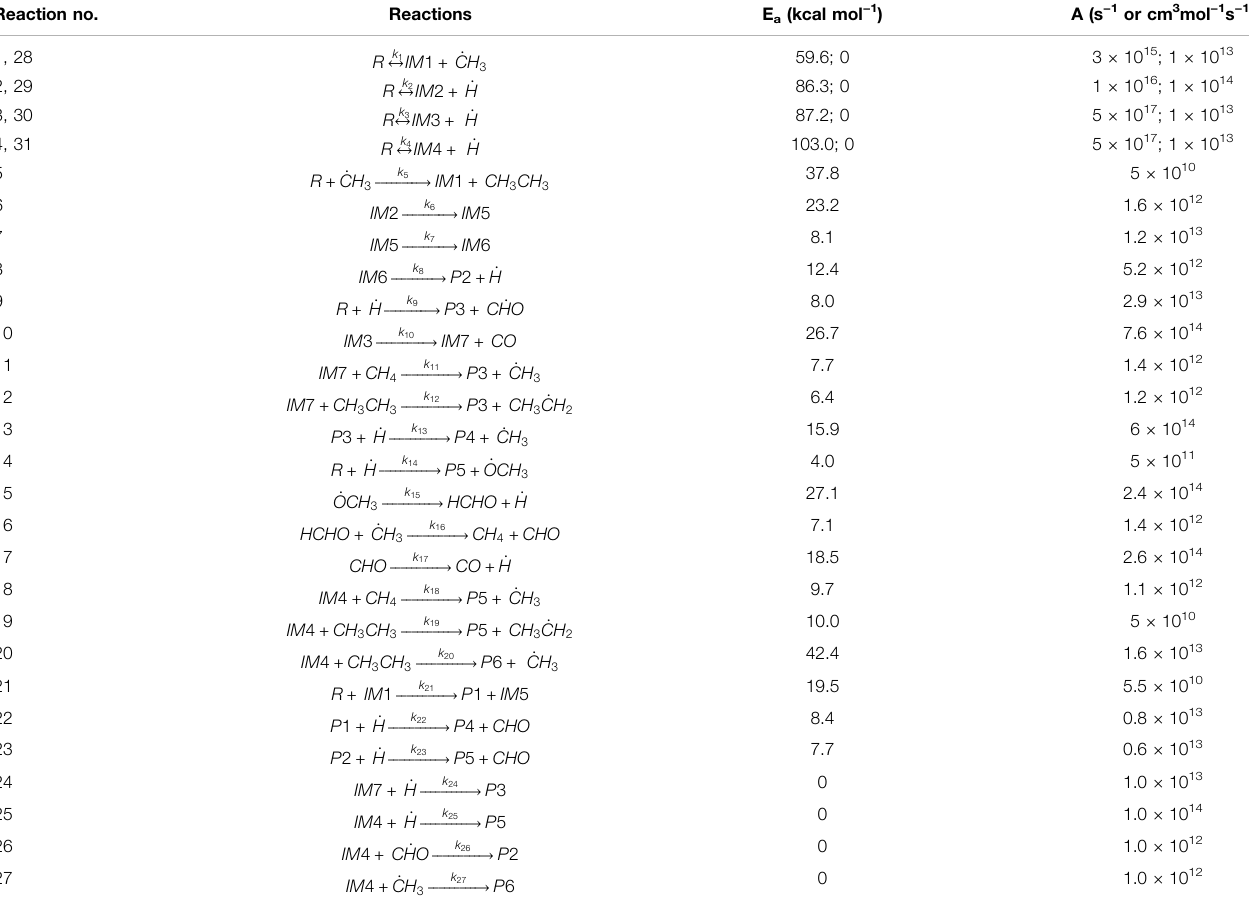
TABLE 3 | Kinetic parameters of the elementary reactions in vanillin fast pyrolysis. Reaction no.